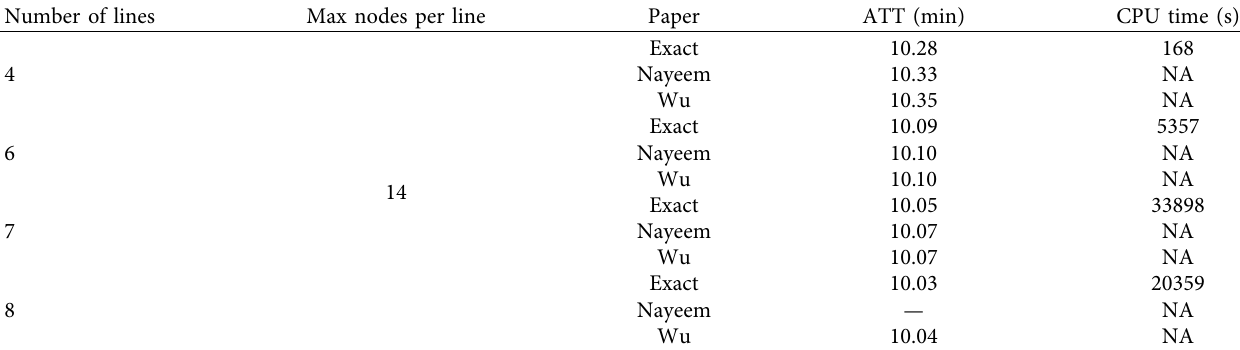
Table 6: Comparison of the exact algorithm with literature for unlimited line length. Number of